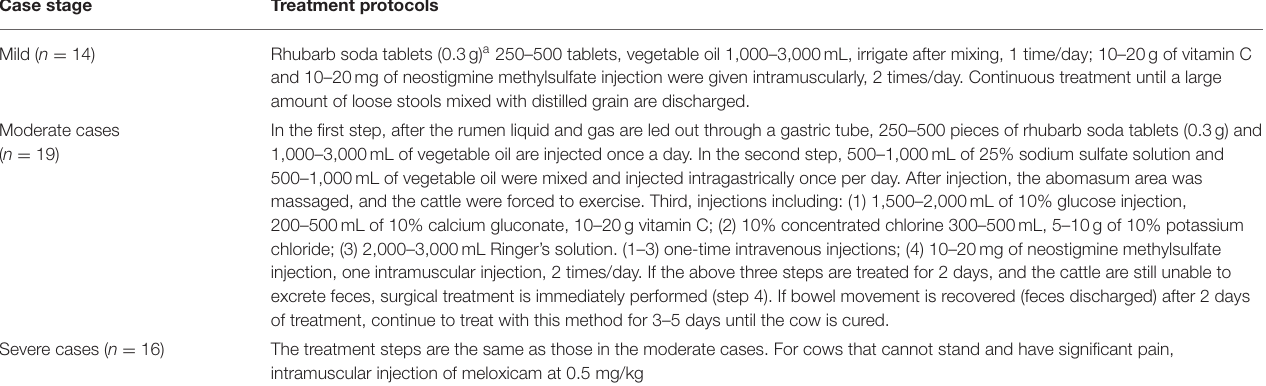
TABLE 2 | Treatment protocols for 49 beef cattle.